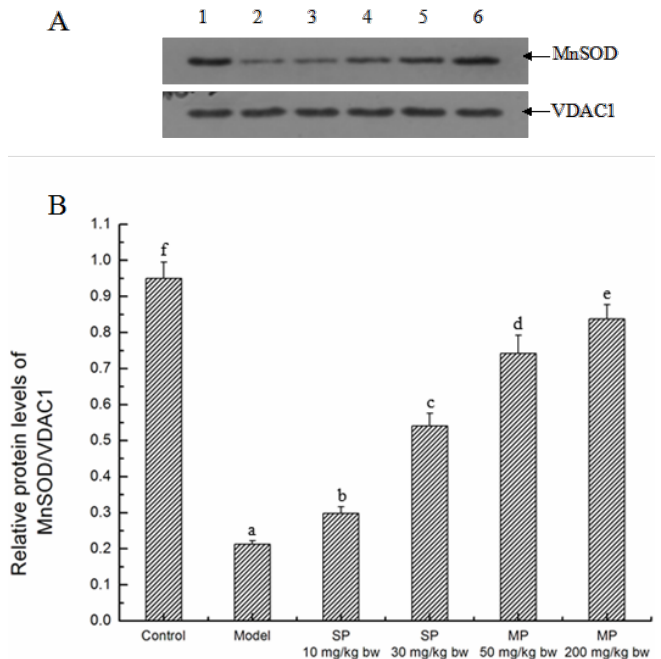
Figure 4. The relative protein expressions of MnSOD in each group. ( A ) Representative western blot for MnSOD, VDAC1 was used as internal control; ( B ) Relative protein level of MnSOD/VDAC1. Values not sharing a common letter (a, b, c, d, e, f) differ significantly at p < 0.05. SP, synthetic pentapeptide; MP, mixed corn peptides. Numbers 1–6